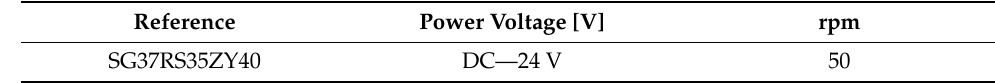
Table 3. Characteristics of the spine closing motor.